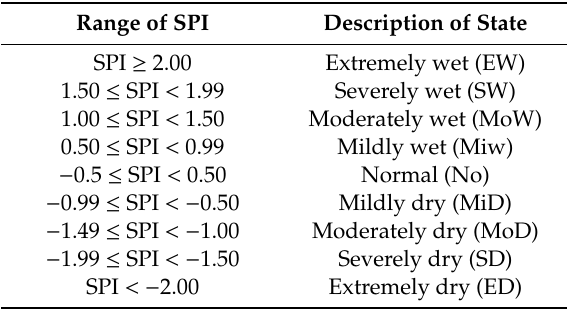
Table 1. Standardized precipitation index (SPI) classification